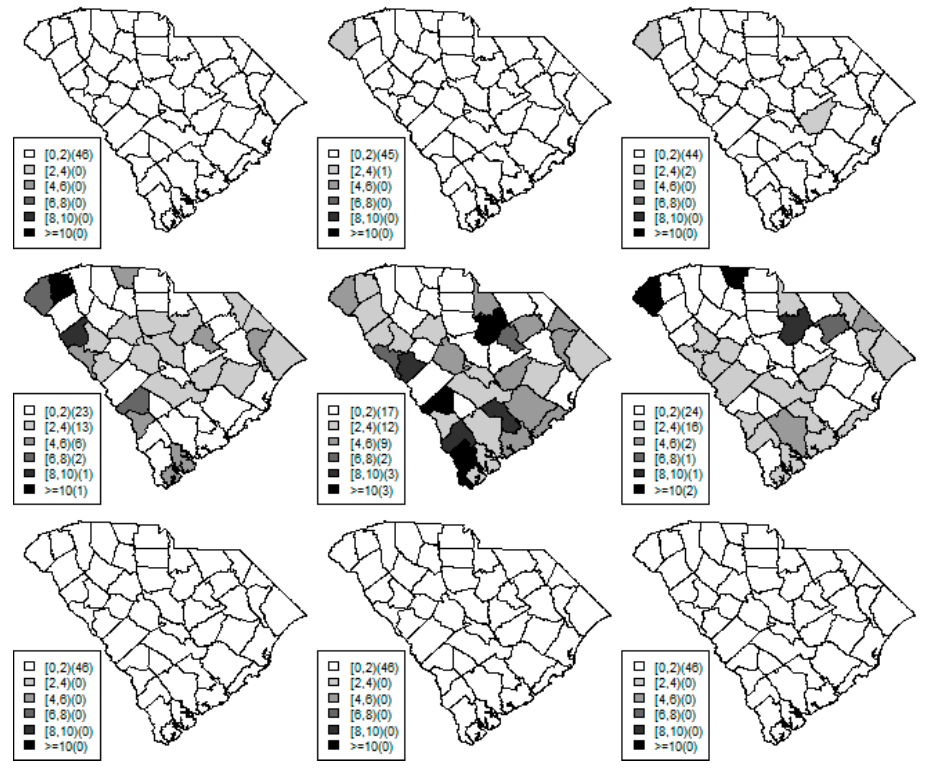
Figure 3. Maps of the estimated 10th quantile relative risks from the proposed quantile ( top row) and mean ( middle row) regression models versus the simulated relative risks ( bottom row) during years 2 (left) to 4 (right).